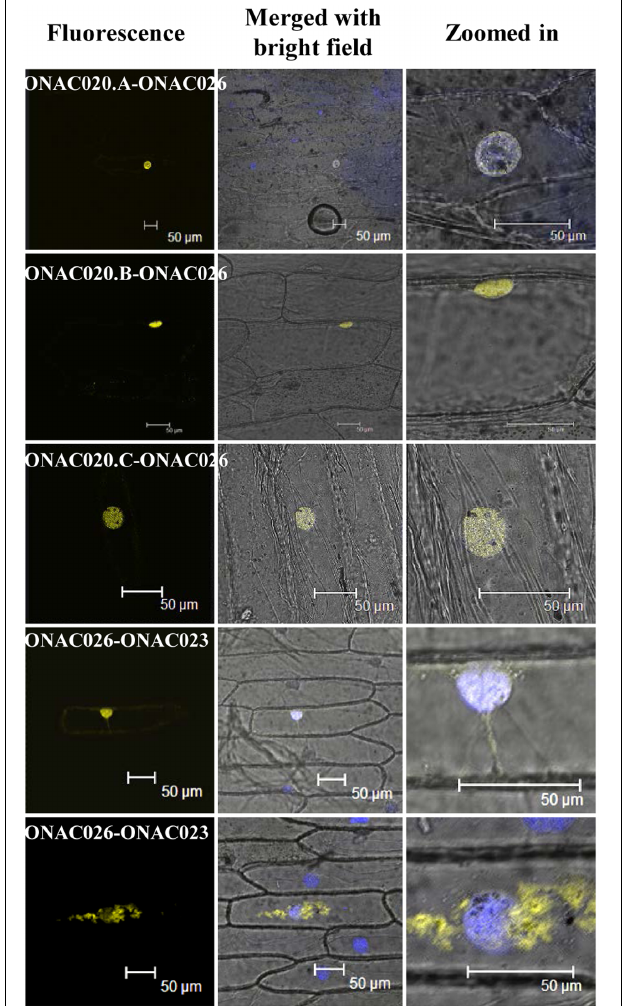
FIGURE 7 | Interactions amongst the NAC proteins by BiFC. The left column indicates the localization image of the reconstituted YFP protein at 514 nm. The middle column is the merger of bright field and fluorescence images while the right column shows an enlarged image of the nucleus. The nucleus has been stained by DAPI dye. The interacting protein names have been mentioned and the scale bar indicates 50 µ